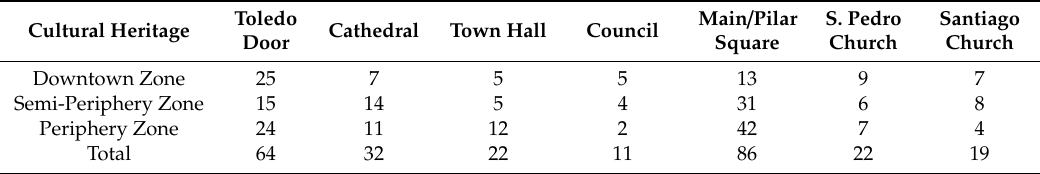
Table A3. Results of answers related to cultural heritage.